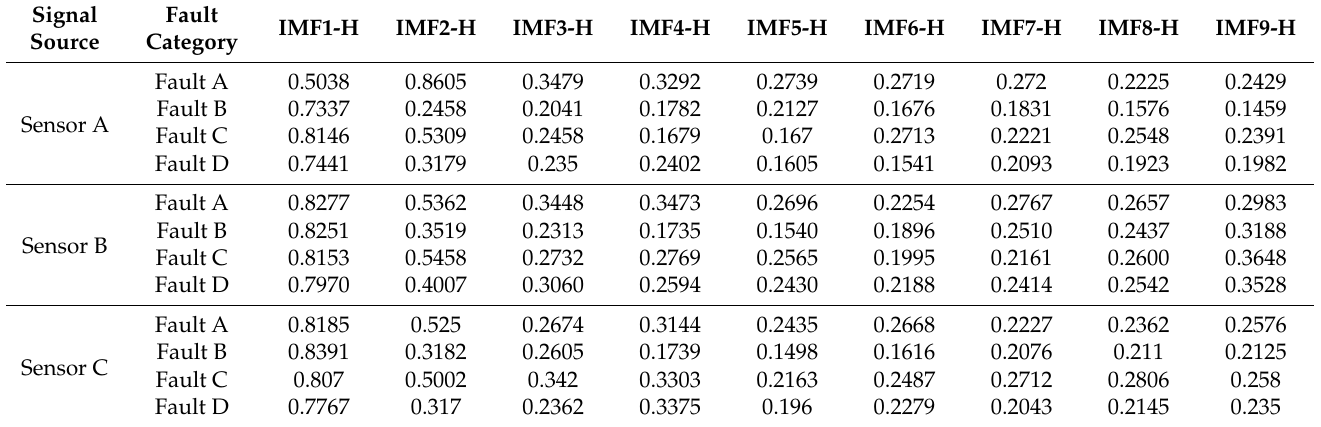
Table 4. IMF-H exponent numerical value of metal particle faults.